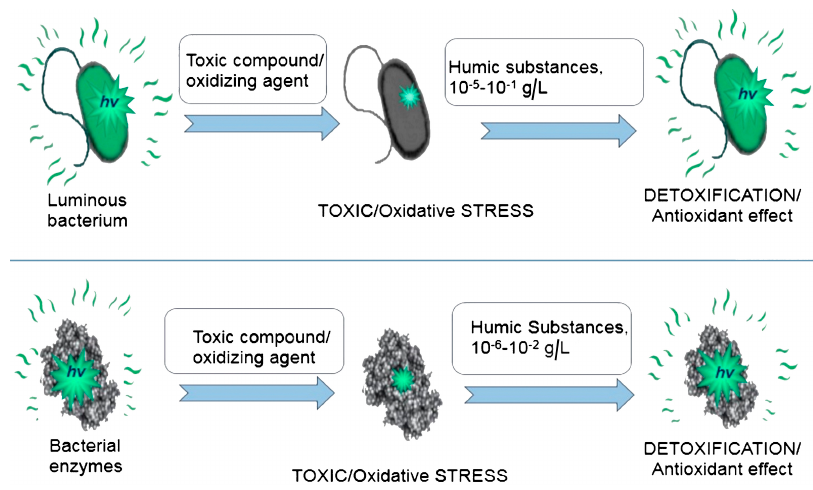
Figure 11. Principle of antioxidant efficiency evaluation using bacteria-based (upper path) and enzyme-based (lower path) bioluminescent assays.